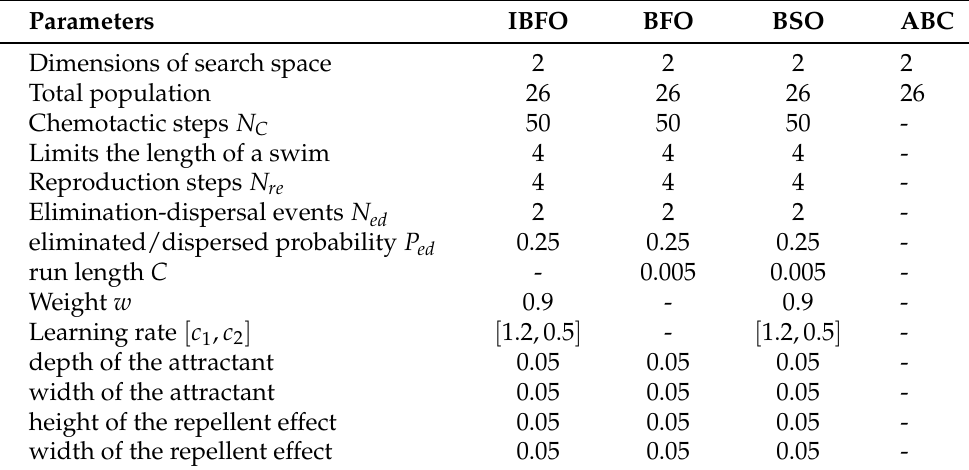
Table 1. Initialized parameters for IBFO, BFO, BSO, and ABC.